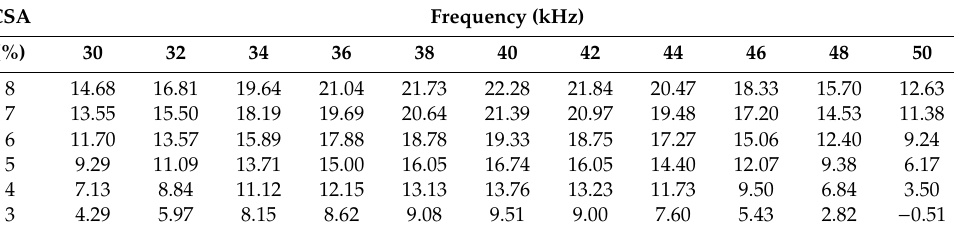
Table A2. SNR achieved from the general propagation routine (in dB).